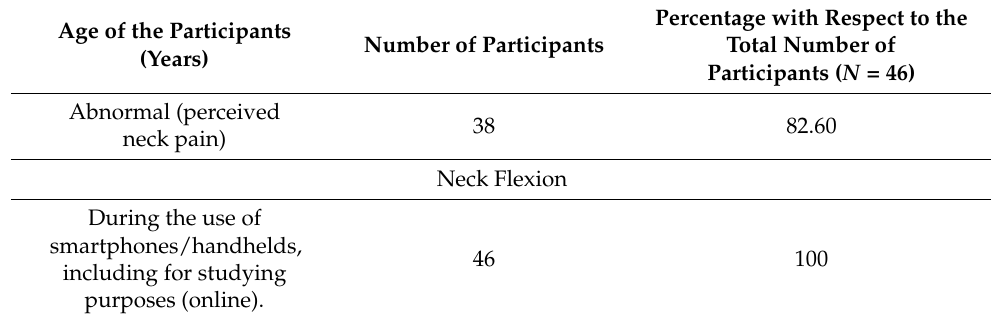
Percentage with Respect to the Number of Participants Total Number of Participants ( N = 46) 38 82.60 Neck Flexion 46